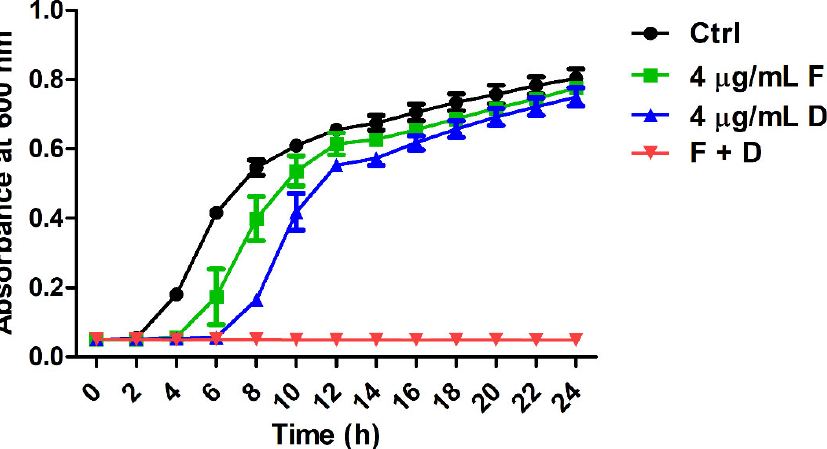
Figure 1. The growth of E. coli KBN12P05816 was analyzed in the presence of fingolimod and doripenem. Each sample was plated on trypticase soy broth (TSB) plates and incubated at 37 °C for 24 h. ( ● ) Untreated controls, ( ■ ) 4 μ g/mL of fingolimod, ( ▲ ) 4 μ g/mL of doripenem, and ( ▼ ) the combination of 4 µ g/mL of fingolimod and 4 µ g/mL of doripenem.